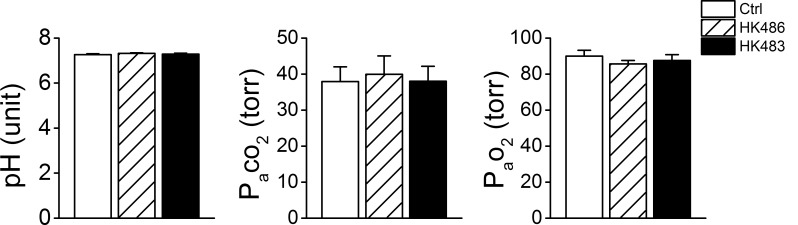
Effects of viral infection on pH and blood gases.Arterial blood was sampled at 3 dpi in anesthetized Ctrl, HK486 and HK483 mice (n = 7/each group). Mean ± SE. There is no difference in blood gases/pH among the three groups at 3 dpi.